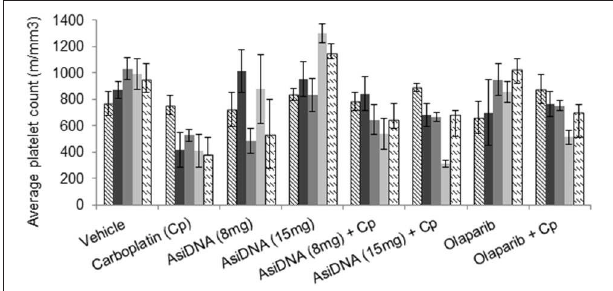
FIGURE 3 | Blood toxicity. Different combinations of carboplatin 80 mg/kg, with AsiDNA 8 or 15mg or olaparib 200 mg/kg were used to treat mice. Counts of platelets before treatment (hatched), 7 days after beginning of first cycle (dark gray), 7 days after second cycle (dark gray), and 7 or 21 days after third cycle (light gray and dashed,